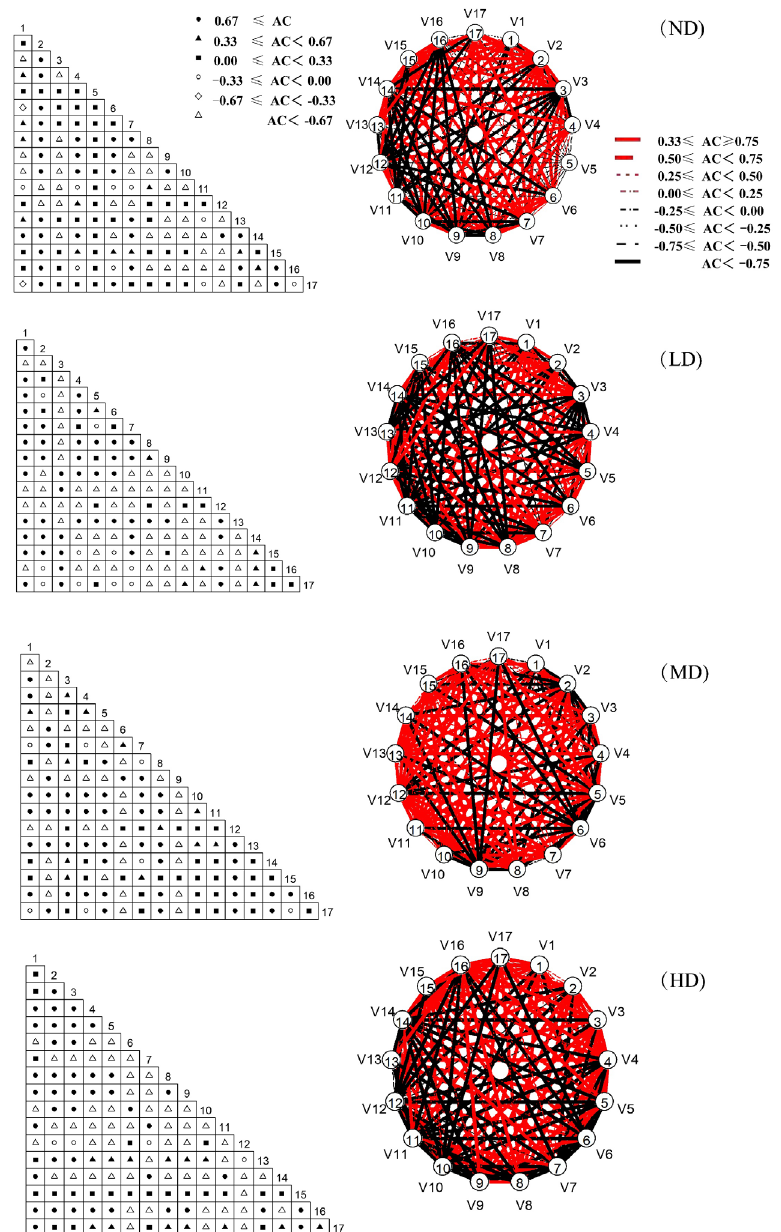
Figure 3. AC (association coefficient) linkage coefficients of major species in different desertification stages in the Qinghai Lake Basin. The numbers 1–17 represent different plant species, and the circular graph on the right represents the government association of different species. ND stands for not desertification, LD for light desertification, MD for moderate desertification, HD for heavy desertification. See Table 1 for the meanings of species numbers.